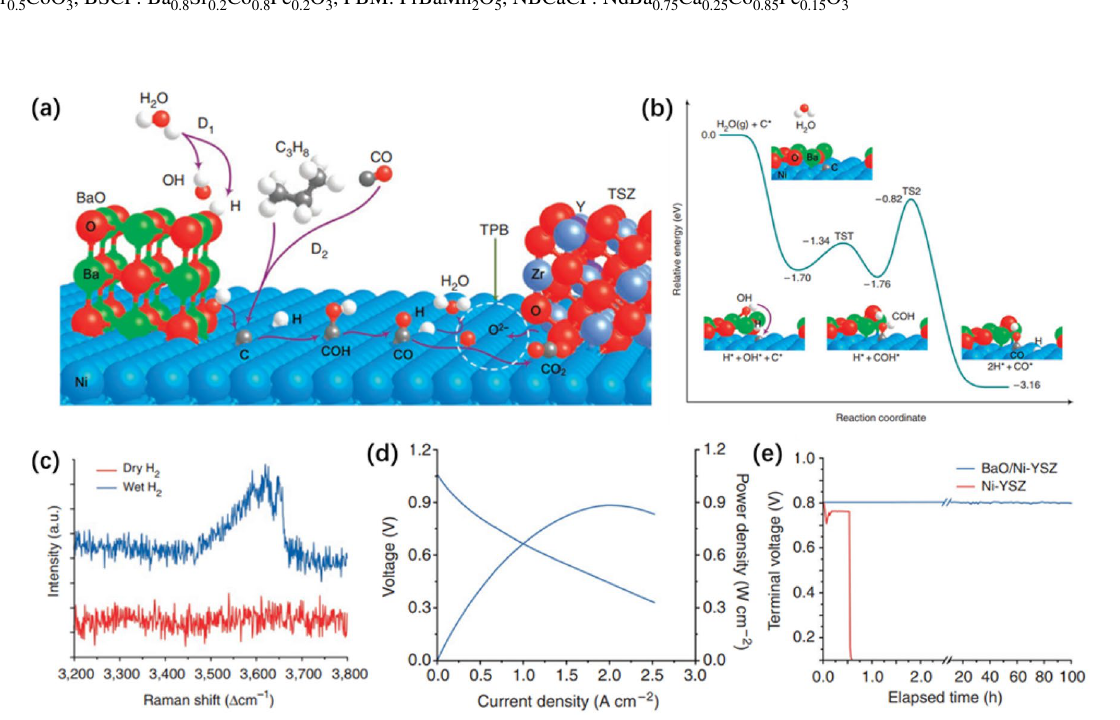
of BaO/Ni–YSZ|YSZ|SDC/LSCF operated at 750 °C when fueled with dry propane and ambient air as oxidant. e Terminal voltages measured at 750 °C as a function of time with the constant current density of 500 mA/cm 2 with dry propane as fuel. Reproduced with permission [40]. Copyright 2011, Springer